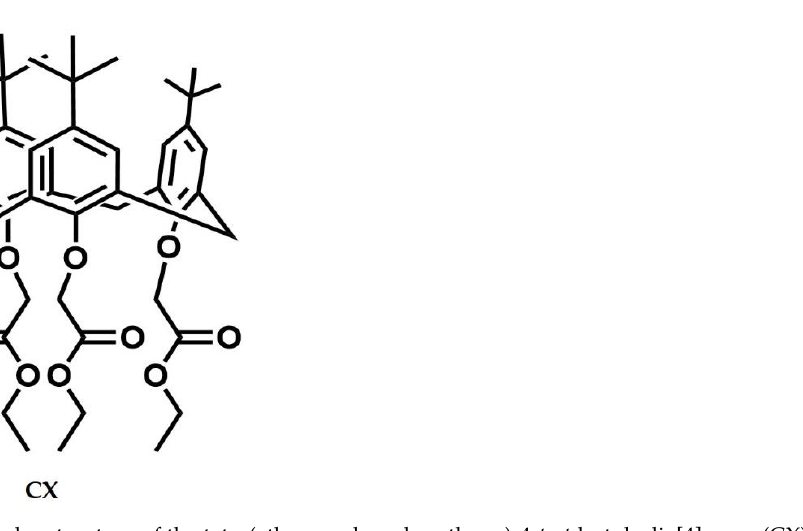
Figure 1. Molecular structure of the tetra(ethoxycarbonyl-methoxy)-4- tert -butylcalix[4]arene (CX).